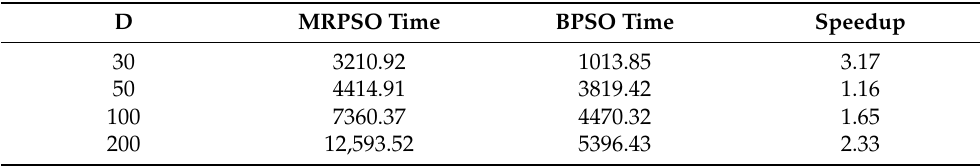
Table 12. MRPSO and BPSO running time and speedup on f 3 .